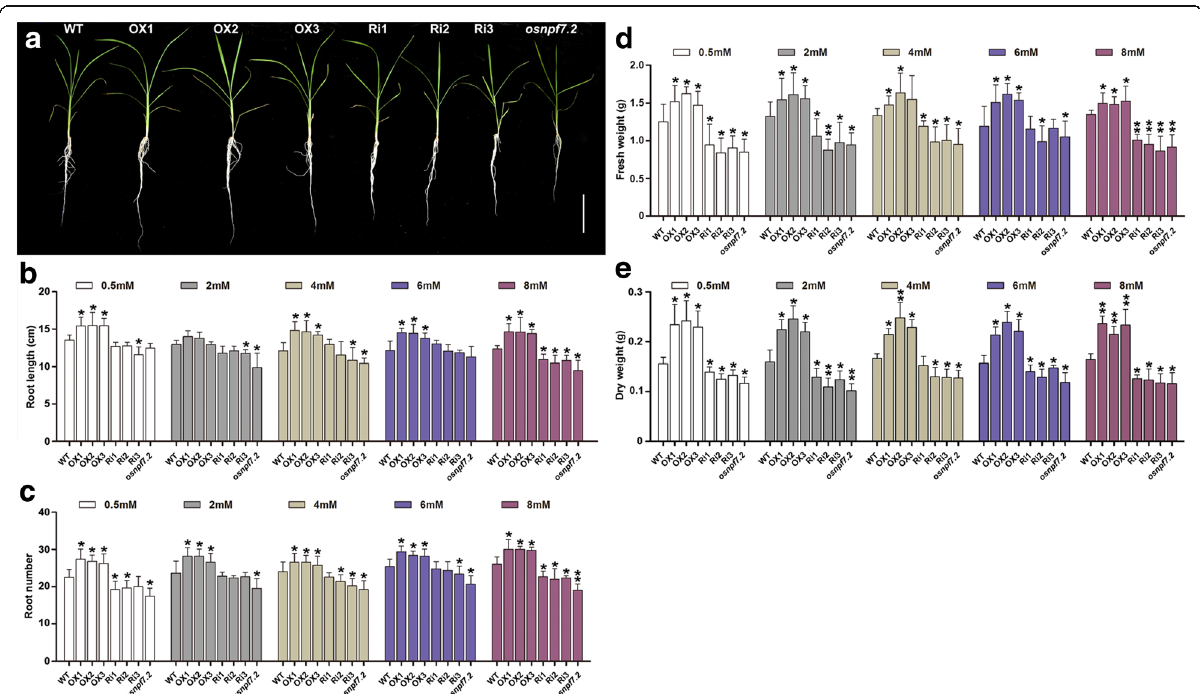
Fig. 3 Altered expression of OsNPF7.2 functioned on rice seedling growth at different nitrate supply. a Phenotypic analysis of seedlings at 31 DAG among WT, OX lines, Ri lines and osnpf7.2 under the 8 mM NaNO 3 supply, respectively. Bar = 10 cm. b-e Statistical analysis of root length ( b ), root number ( c ), fresh weight ( d ) and dry weight ( e ), respectively, among WT, OX lines, Ri lines and osnpf7.2 under the 8 mM NaNO 3 supply. Values in b-e are shown as mean ± SD (n = 20) from three replicates; “ * ” and “ ** ” indicated significant differences at P < 0.05 and P < 0.01,